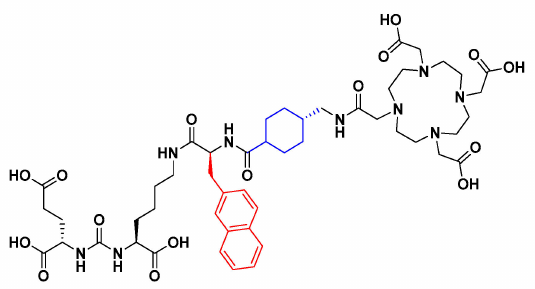
Figure 1. Chemical structure of PSMA-617. The naphthylic linker structure is highlighted in red and the cyclohexyl linker structure in blue.